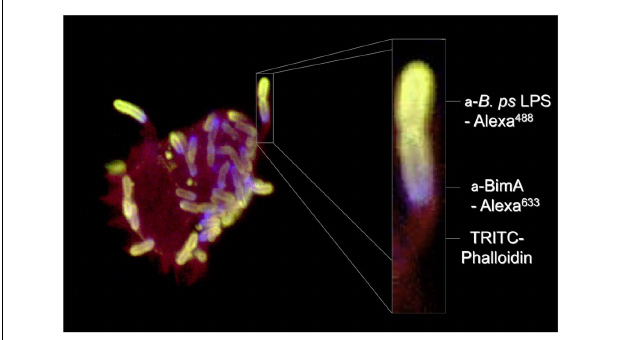
FIGURE 1 |Actin-based motility of B. pseudomallei in a J774.2 murine macrophage-like cell 8h post-infection. B. pseudomallei was detected with antibodies to its lipopolysaccharide (green) and BimA was detected with a panel of specific monoclonal antibodies (blue). Polymerized (F-) actin was stained red with fluorophore-labeled